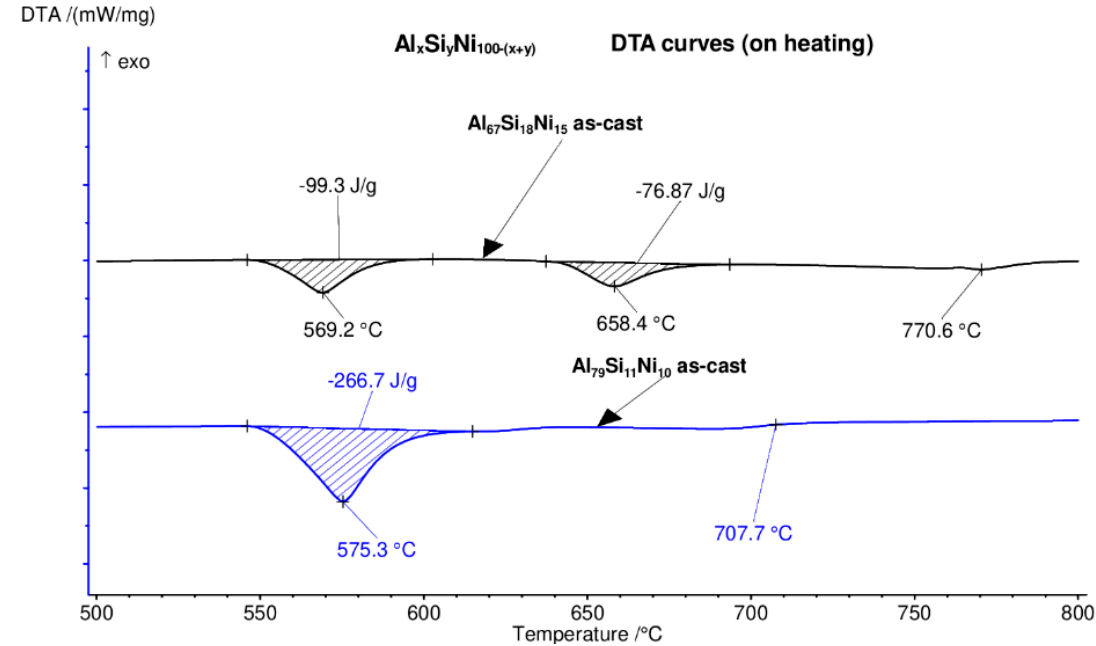
Figure 9. Differential thermal analysis (DTA) heating curves for the Al 79 Si 11 Ni 10 and Al 67 Si 18 Ni 15 alloys, in bulk form. The endothermic peaks signify melting events, firstly of the eutectic, followed by the intermetallic compounds.